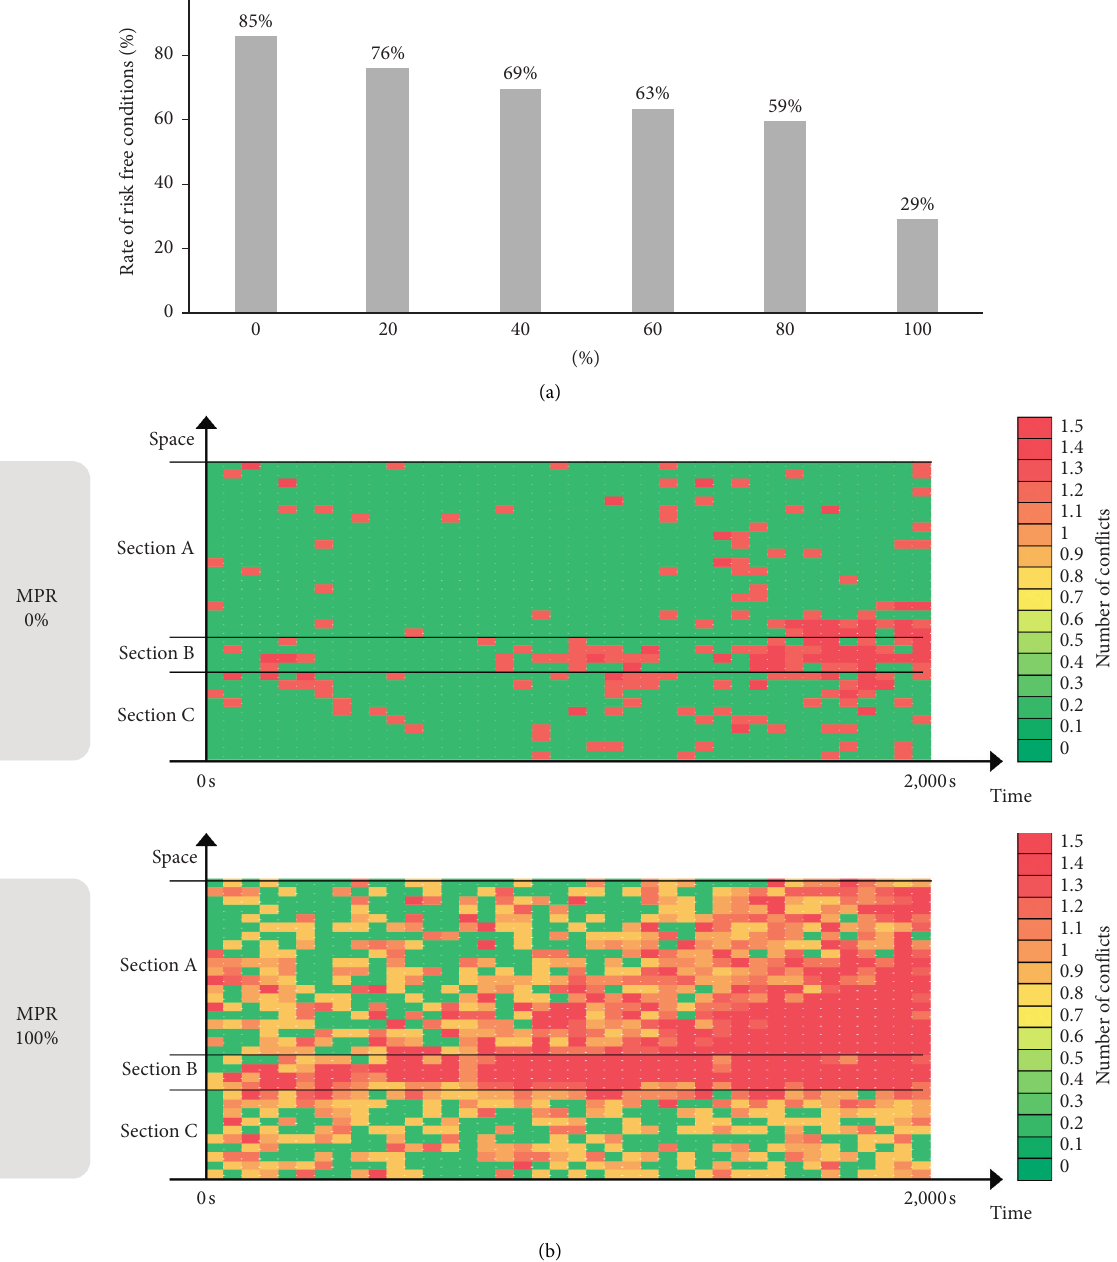
Figure 5: Analysis results of lane change conflict, (a) Rate of risk-free conditions by MPR and (b) spatiotemporal diagram of conflicts by MPR 0%,